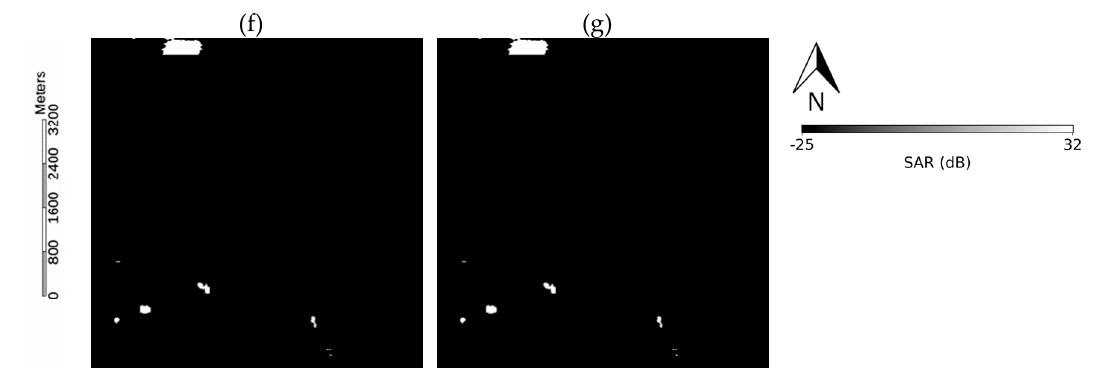
Figure 9. Results of the Bangkok site in the first area at 14°1’2.26”N 100°41’15.99”E. The size of each image is 6 × 6 km (for SAR pairs 27 November 2008/15 January 2010: ( a ) Time 1 SAR image; ( b ) Time 2 SAR image; ( c ) ground truth; ( d ) result of U-net; ( e ) proposed result).